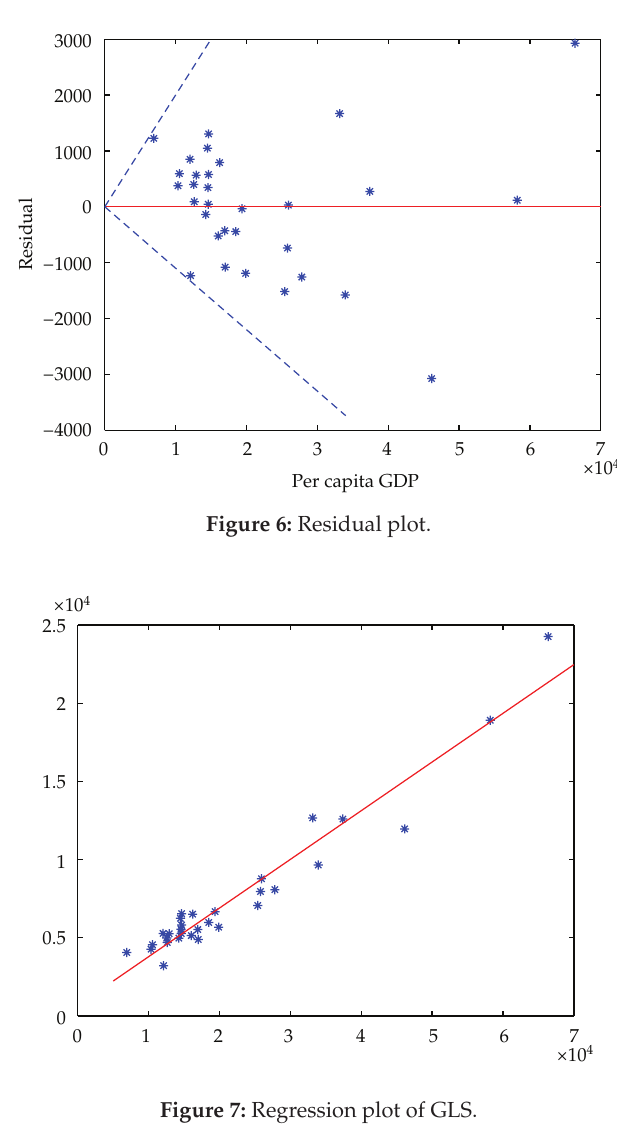
Figure 7: Regression plot of